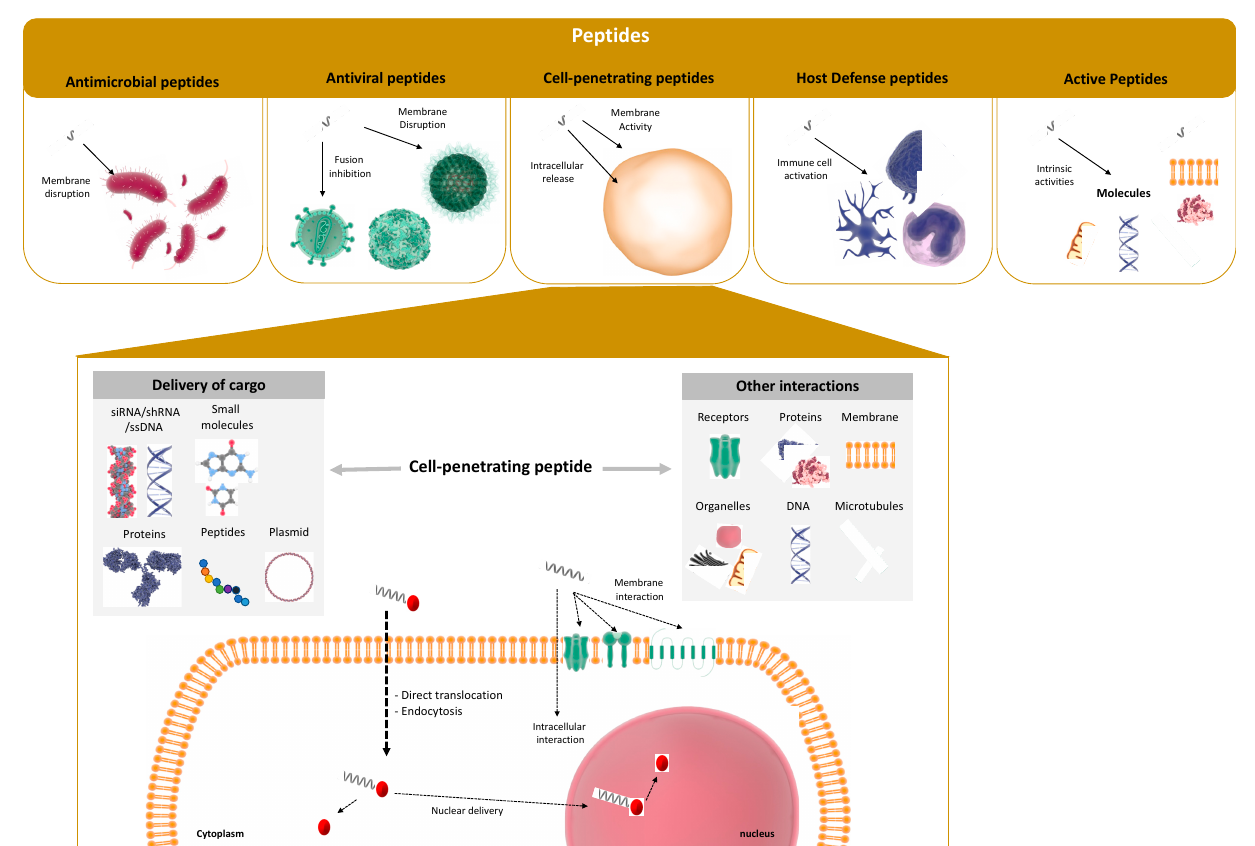
Figure 1. Schematic representation of the different types of peptides available and their different activities. In-depth representation of cell-penetrating peptides as delivery molecules and potential other interactions.